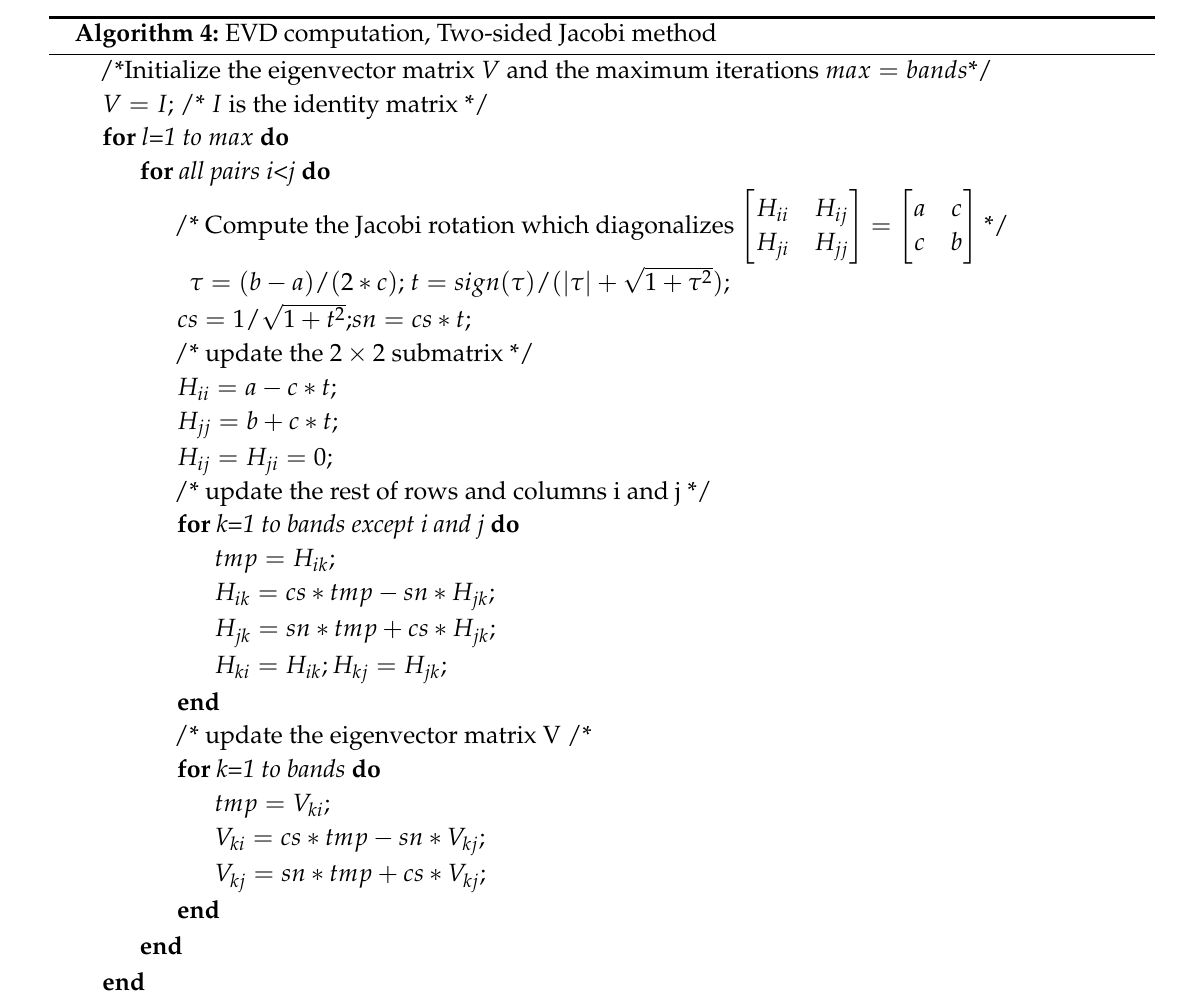
Algorithm 4: EVD computation, Two-sided Jacobi